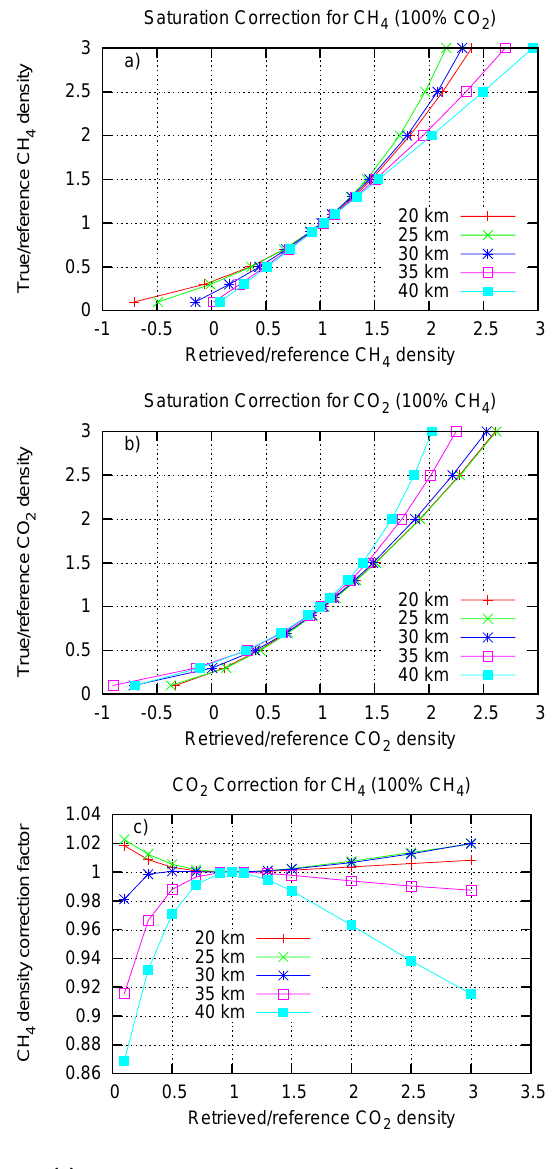
Fig. 2. (a) Saturation correction for CH 4 as function of altitude and (smoothed) CH 4 concentration. (b) Saturation correction for CO 2 as function of altitude and (smoothed) CO 2 concentration. (c) CO 2 correction factor for CH 4 as function of altitude and (saturation cor- rected) CO 2